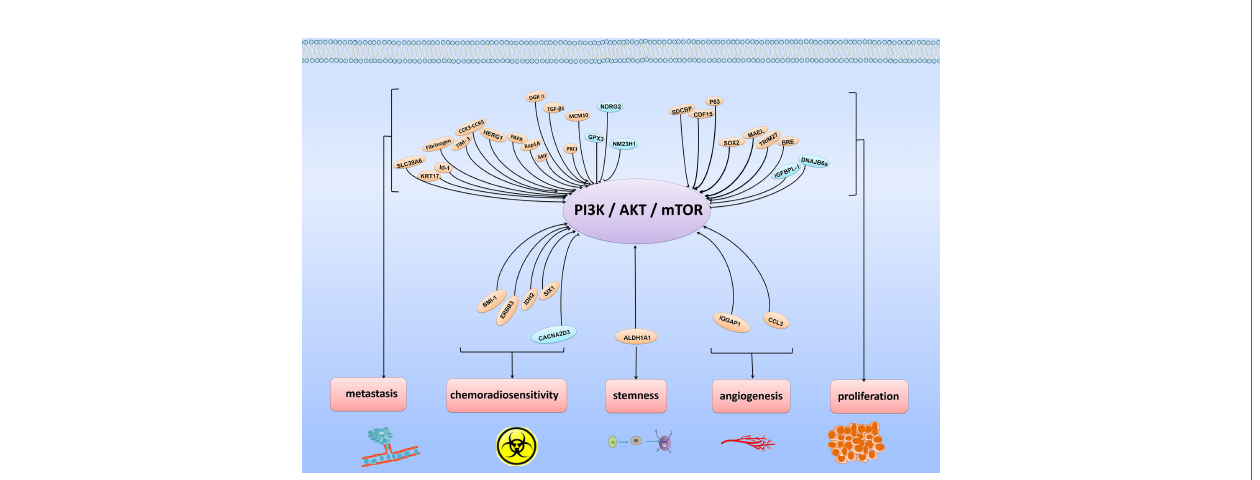
FIGURE 1 | Various regulatory molecules of PI3K/Akt/mTOR signaling pathway and physiological functions of these molecules. The PI3K/Akt/mTOR signaling pathway is usually regulated by various signaling molecules. By targeting major molecules in the PI3K/Akt/mTOR signaling pathway, these molecules play positive or negative roles in regulating cancer proliferation, metastasis, angiogenesis, stemness and